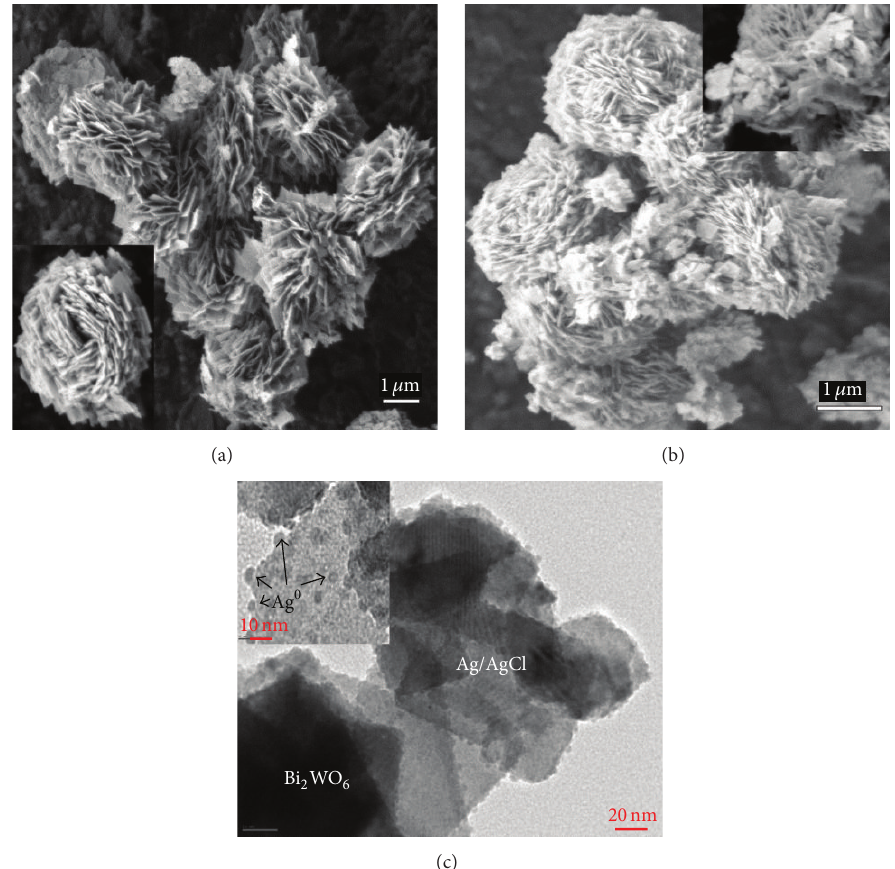
Figure 4: SEM images of pure Bi 2 WO 6 (a) and Ag/AgCl (10wt%)-Bi 2 WO 6 composite (b), and TEM images of Ag/AgCl (10wt%)-Bi 2 WO 6 composite (c).